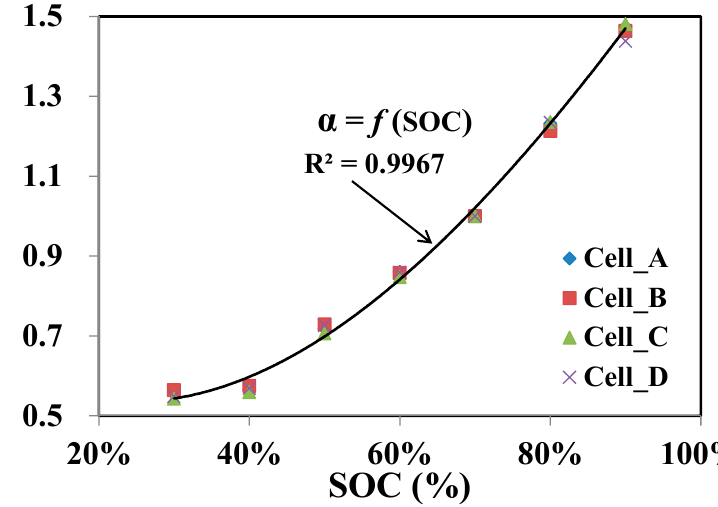
Figure 5. Correlations of factor α with SOC for the four tested cells.